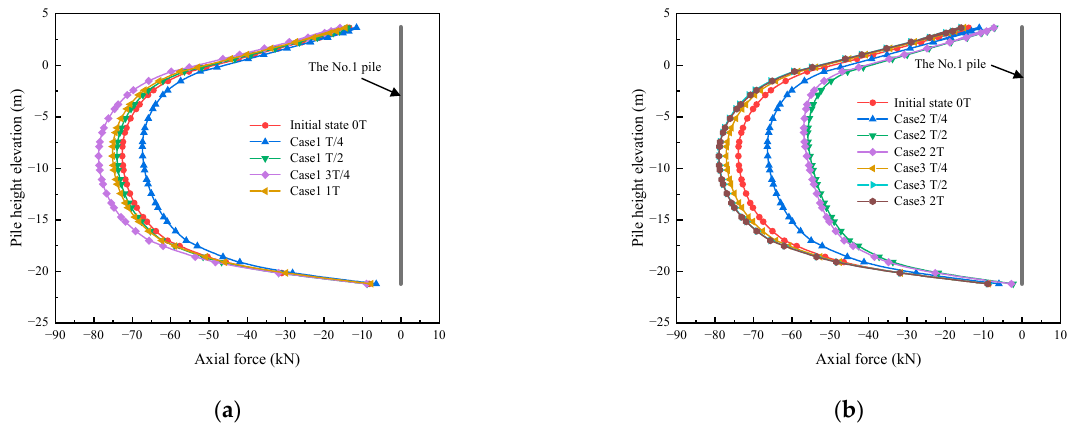
Figure 10. Axial force distribution of the No. 1 pile body under three cases: ( a ) Axial force distribution of the No. 1 pile body under tidal action. ( b ) Axial force distribution of the No. 1 pile body under sudden water level rise and drop.